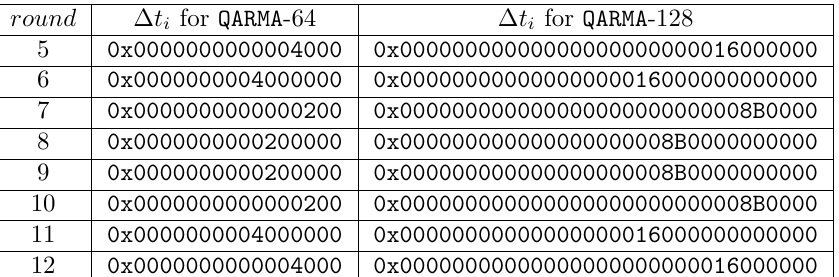
Table 12: Difference of Round Tweak for No. 7